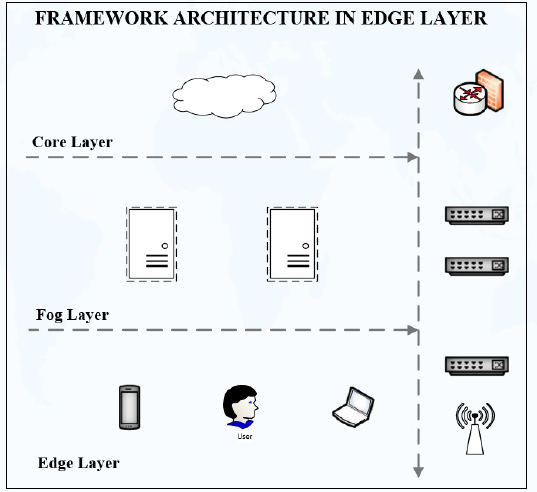
Figure 5. Architecture of edge